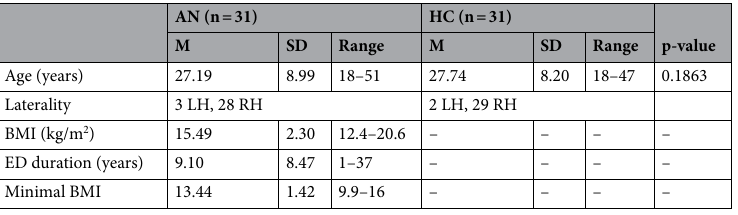
Table 1. Demographic and clinical characteristics. LH: left-handed, RH: right-handed, AN-BP: anorexia nervosa binge purge subtype, AN-R: anorexia nervosa restrictive subtype.